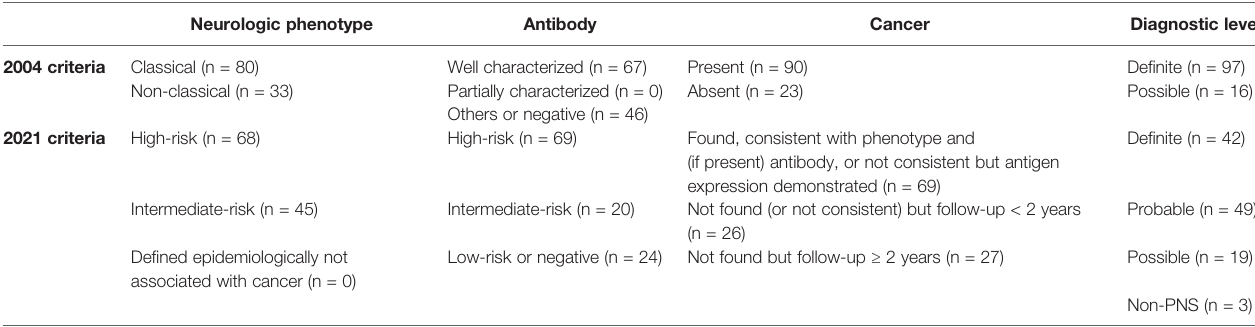
TABLE 2 | De fi nition and classi fi cation of the 2